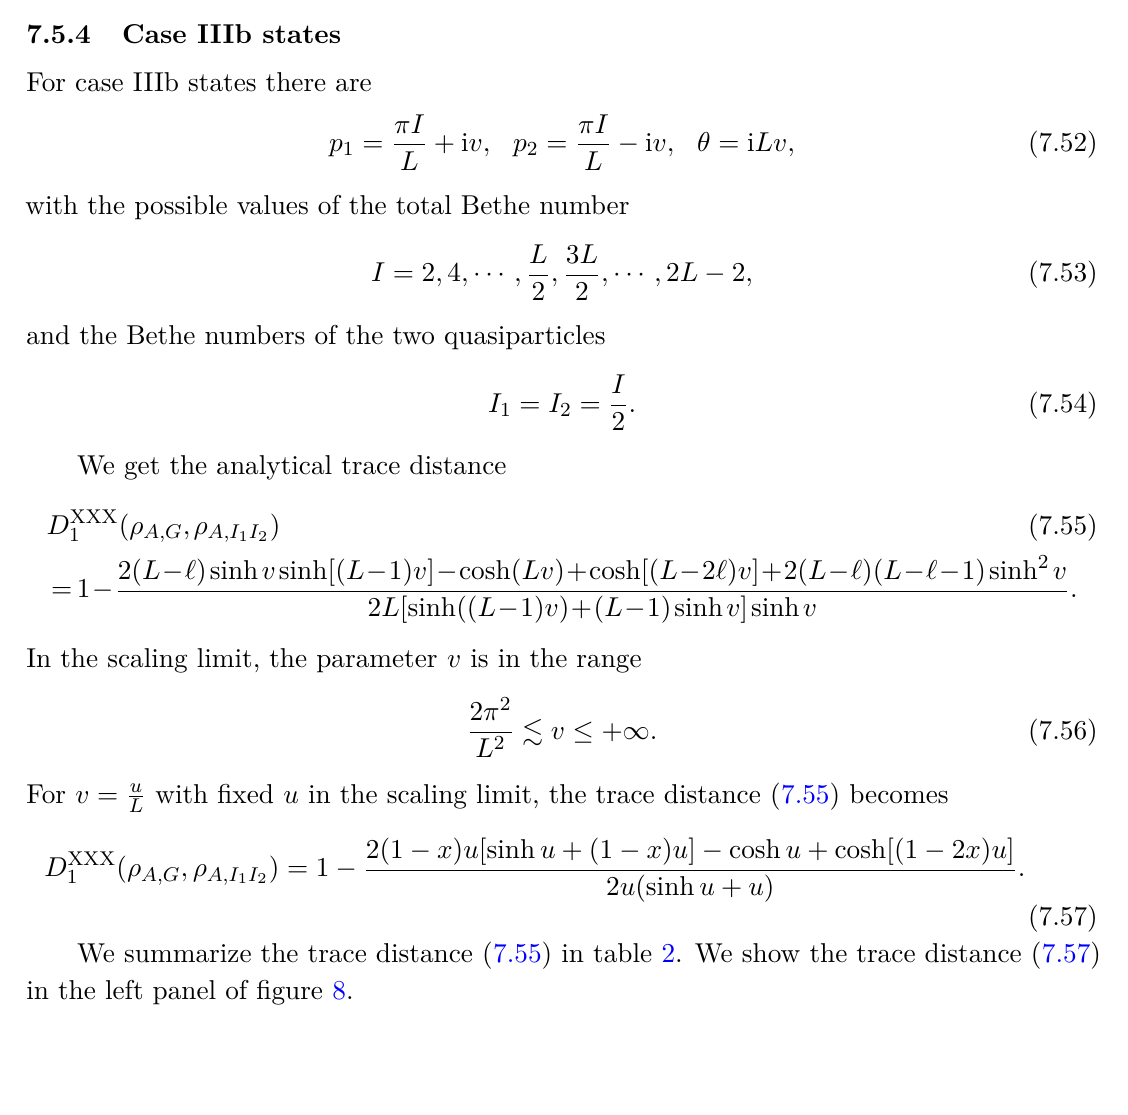
Figure 8 . The subsystem trace distances between the ground state and the case IIIa double-particle bound states D XXX ( ρ ) (7.51) (left) and the trace distance between the ground state and A,G , ρ A,I 1 I 2 1 the case IIIb double-particle bound states D XXX ( ρ ) (7.57) (right) in the XXX chain. The A,G , ρ A,I 1 I 2 1 horizonal axes u is defined as v = u . In the left and right panels, the dotted lines are the lower L bound of the trace distance D ( ρ ) = x . In the right panel, the dashed lines are the upper 1 A,G , ρ A,k bound D bos ( ρ ) = x (1 − x ) A,G , ρ A,k 2 1